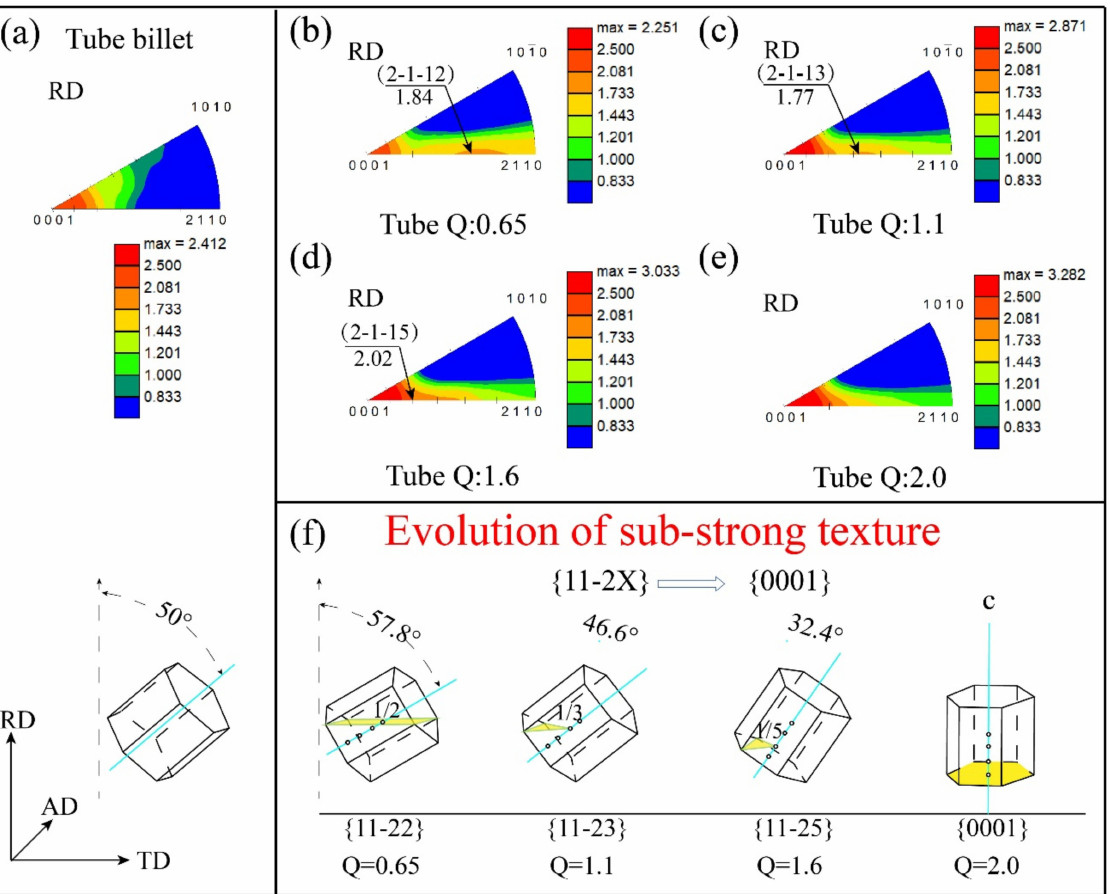
Figure 5. Radial direction inverse pole figures and Grain orientation of sub-strong texture of rolled tubes with different ‘Q’